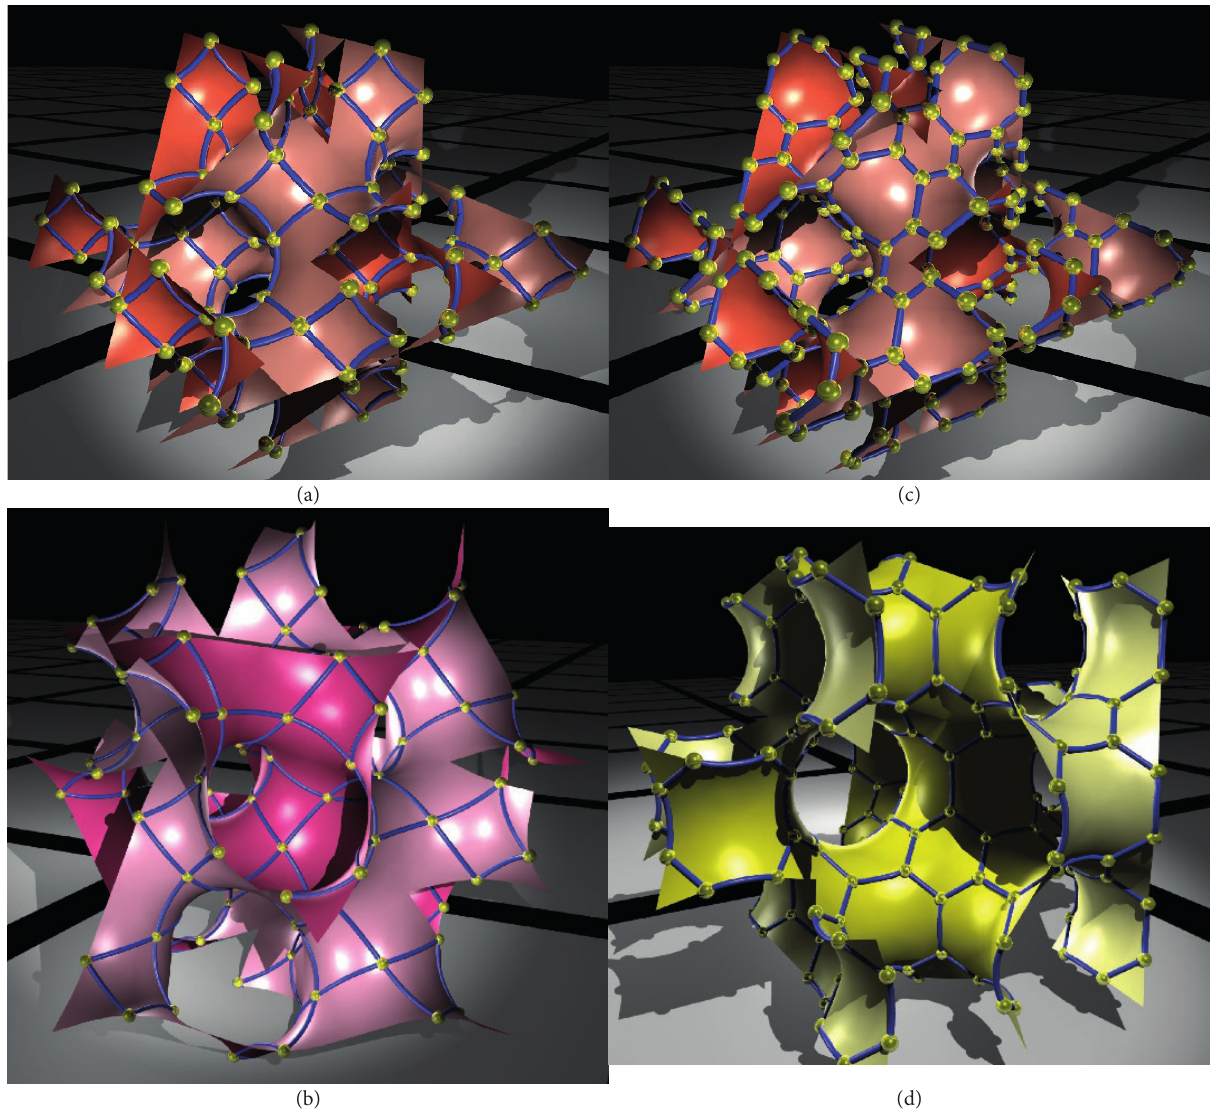
Figure 13. (a): The sodalite zeolite framework lying in the D-surface. Vertices of the framework occupy identical cartesian locations to those in Fig. 2, the edges have been curved to lie in the surface. (b): Fragment of the analcime framework in the D surface, marked in black on the surface. (c), (d): Two schwarzite frameworks: polybenzene D and P. (Pictures courtesy of Stuart